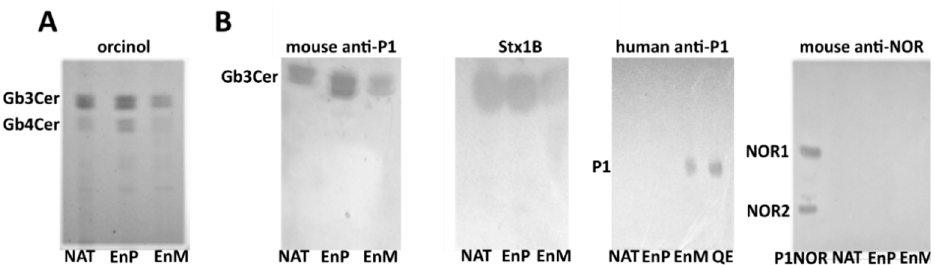
Figure 2. HPTLC and immuno-overlays of neutral glycosphingolipids isolated from 2102Ep cells. ( A ) orcinol staining; ( B ) immuno-overlays of mouse anti-P1, human anti-P1 and anti-NOR (nor118) antibodies and Stx1B. NAT: nontransfected 2102Ep cells, EnM: 2102Ep cells transfected with the vector encoding enzyme M; EnP: 2102Ep cells transfected with the vector encoding enzyme P; P1NOR: neutral GSLs isolated from human RBCs with P 1 NOR phenotype, QE: neutral GSLs isolated from 2102Ep cells transfected with vector encoding human Gb3/CD77 synthase with p.Q211E substitution (as a positive control for the anti-NOR antibody). Positions of bands representing individual GSLs are shown on the left.